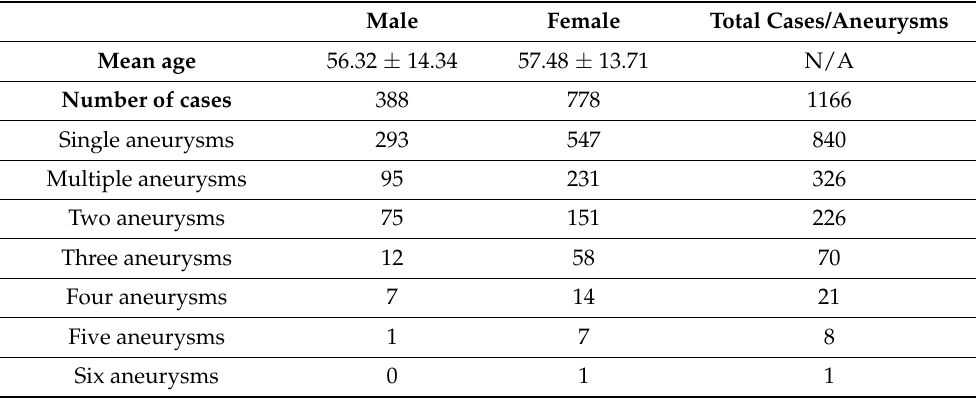
Table 1. Case group